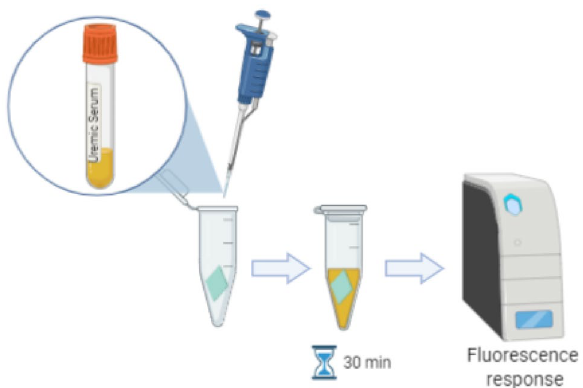
Figure 4. Illustration of uremic serum incubation with different membrane materials. The serum collected from HD patients was added to an Eppendorf tube containing a small sample of membrane material (in green). The interaction took place for 30 min after which the membrane sample was removed and the serum analyzed based on fluorescence response